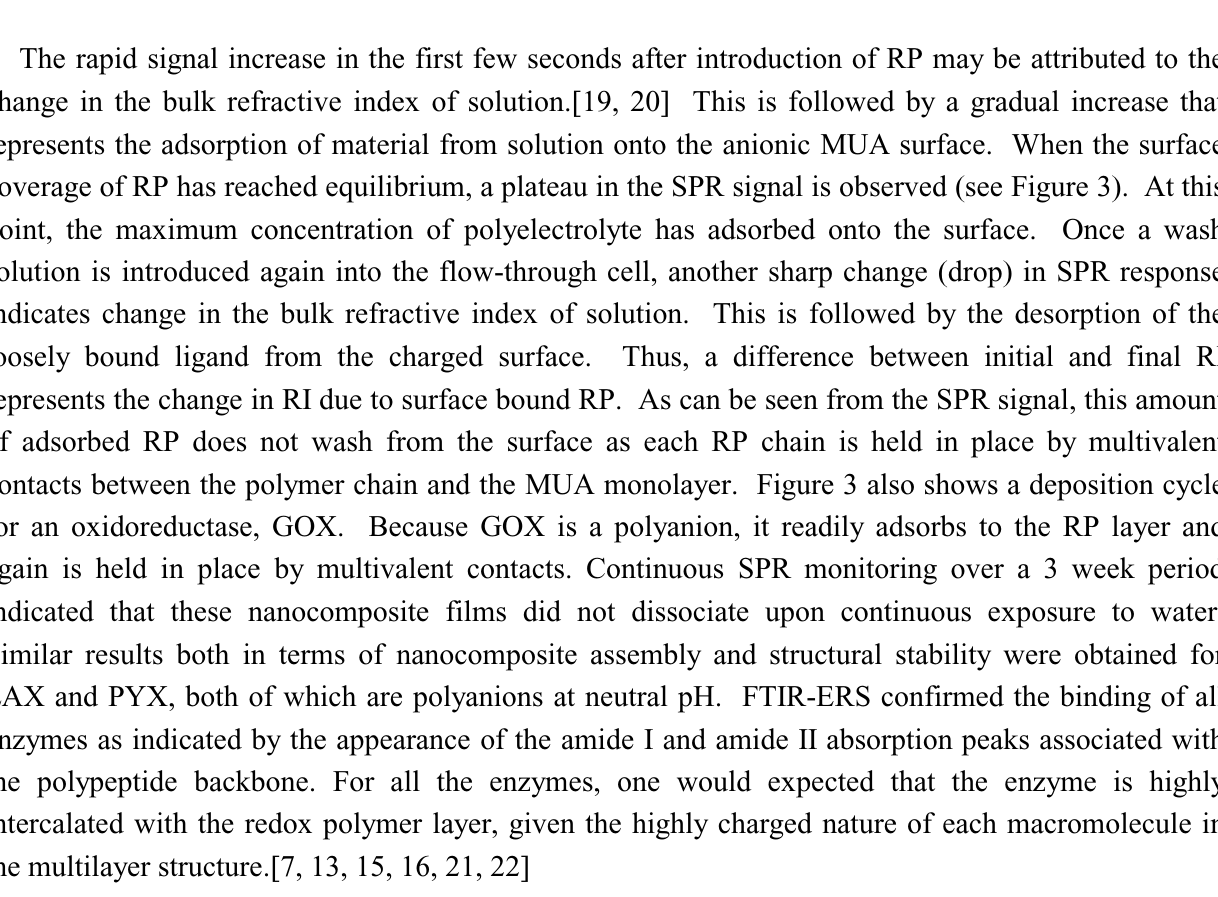
Figure 2 . Schematic of the nanocomposite structure created by the layer-by-layer deposition of alternating polyanionic and polycationic films on